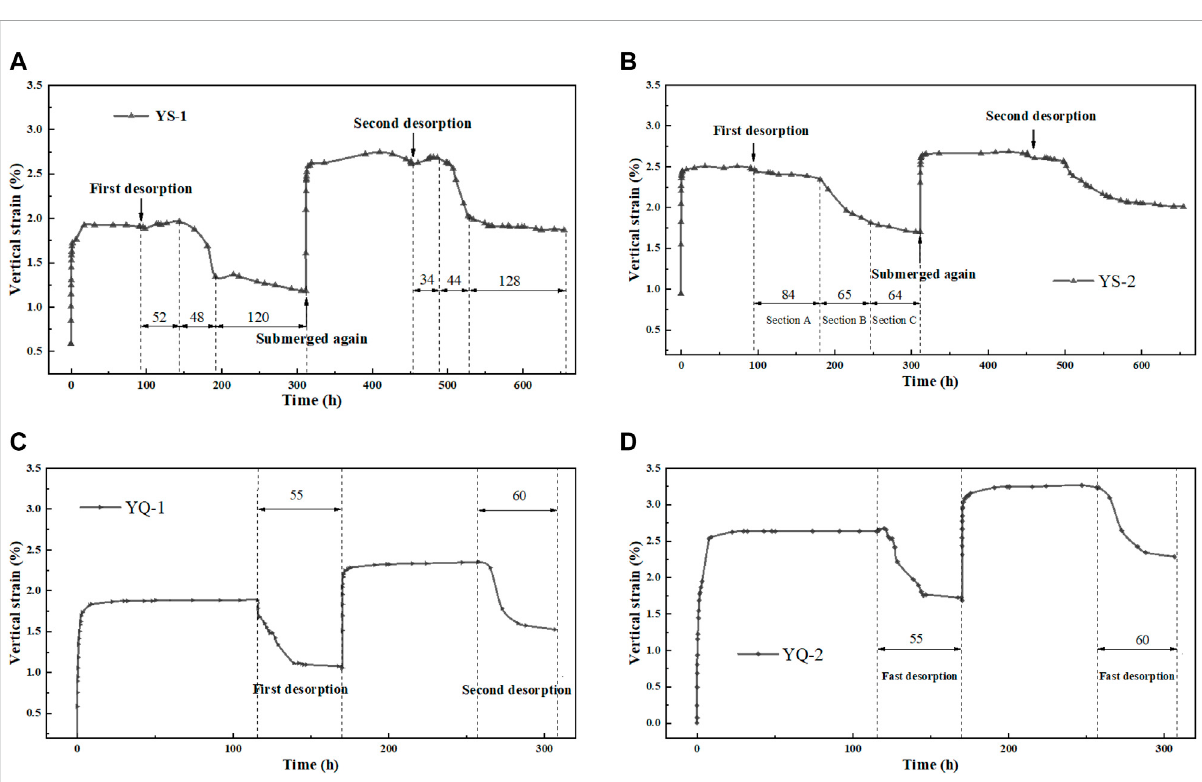
Time-effect characteristic curve of dry-wet deformation. (A) Dry at room temperature with initial water content of 5%; (B) Dry at room temperaturewithinitialwatercontentof3%; (C) Dryinadryingovenat60 ° Cwithinitialwatercontentof5%and (D) Dryinadryingovenat60 ° Cwith initial water content of